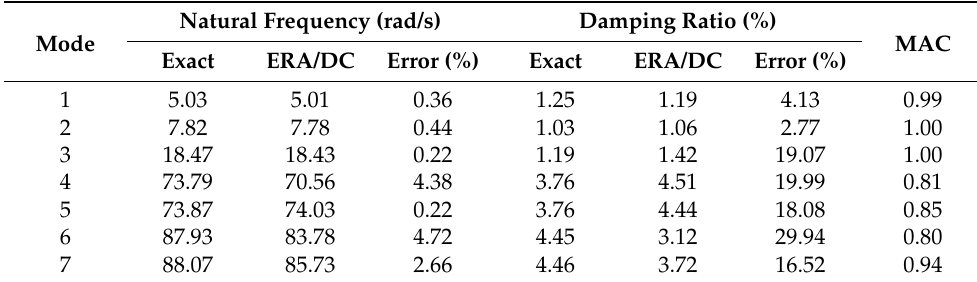
Figure 13. Mode shapes of seven-DOF car model (the solid line is an analytic solution, the dotted line is ERA/DC identification result).